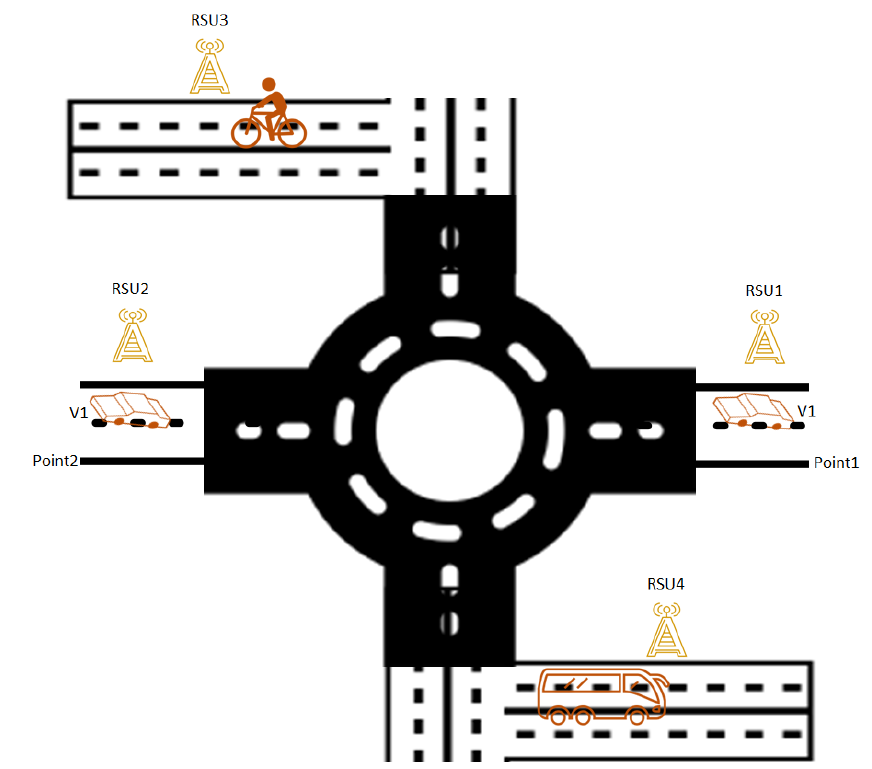
Figure 1. Vehicular